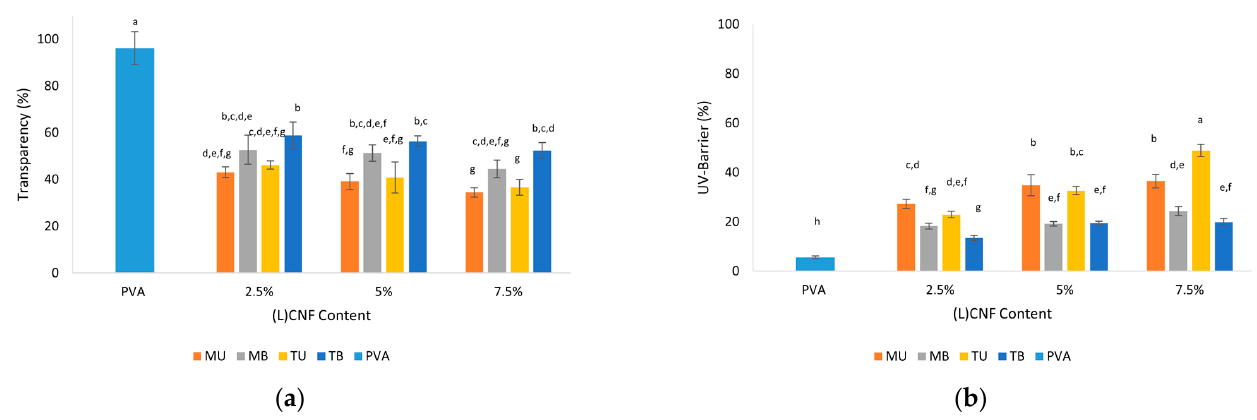
Figure 4. Optical properties of pure PVA and PVA-(L)CNF films formulated with different concentrations. ( a ) Transparency (%); ( b ) UV-barrier (%). Different letters above the bars represent groups significantly different at p < 0.05.